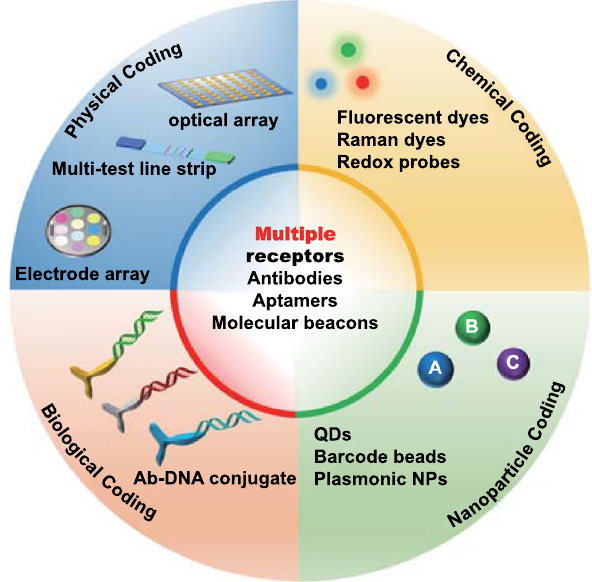
Fig. 2 Main external-coding strategies for EV profiling. Multiplex- ing is typically based on the combination of multiple receptors with one of the four coding strategies. Depending on how the analyte sig- nal is generated and transduced, multiple external codes generated by chemical reporter labelling, physical spatial coding, biological cod- ing, or nanoparticle coding, can be used in association with multiple receptors (QDs = quantum dots, NP =